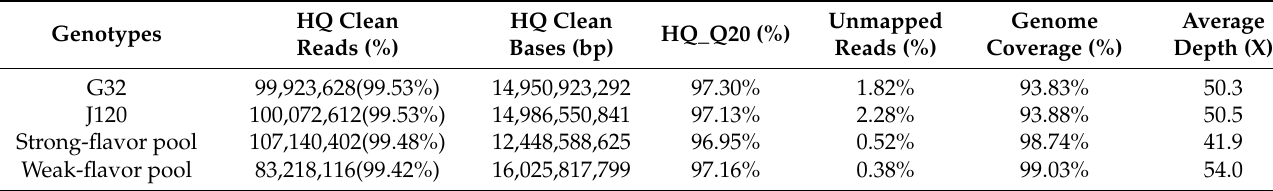
Table 1. Sequencing of parental lines and extreme bulks.